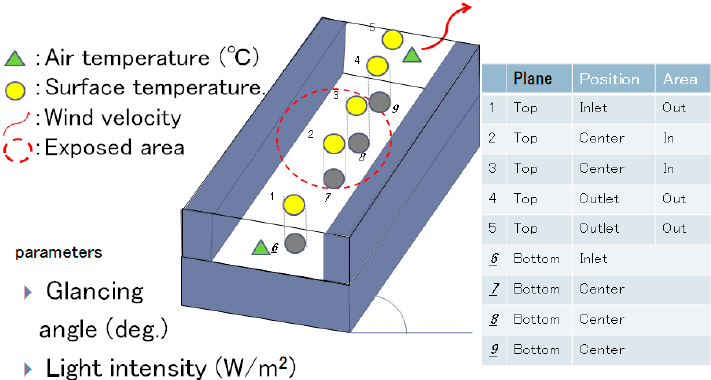
Figure 4. Set-up drawing of small-scale OPV-solar chimney model (Unit: mm).